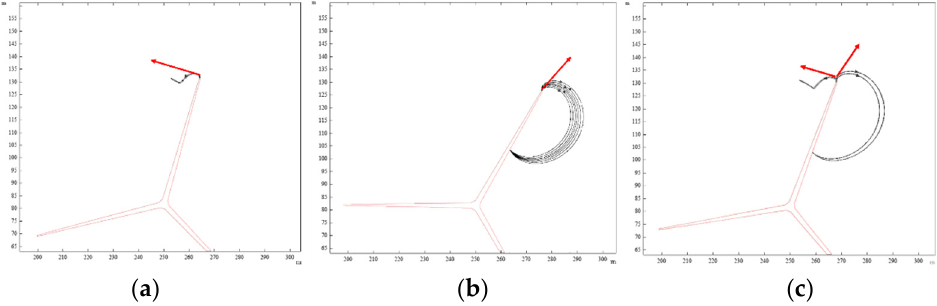
Figure 16. E ‐ field lines near blade tip and the initiation direction of upward leader which is: ( a ) on the back side of blade rotation, ( b ) on the front side of blade rotation, ( c ) possibly on both sides which need to be determined by E ‐ field strength